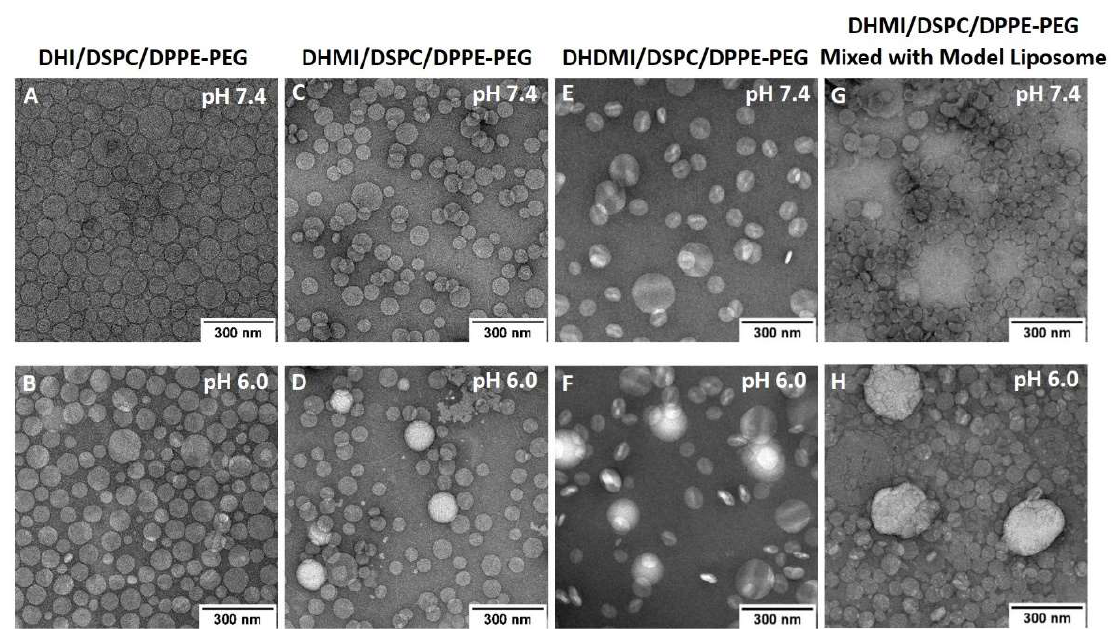
Figure 7. TEM images of DOX-loaded ICL formulations ( A – F ) and mixture of DHMI liposomes with model liposomes ( G , H ) at pH 7.4 ( A , C , E , G ) and pH 6.0 ( B , D , F , H ).